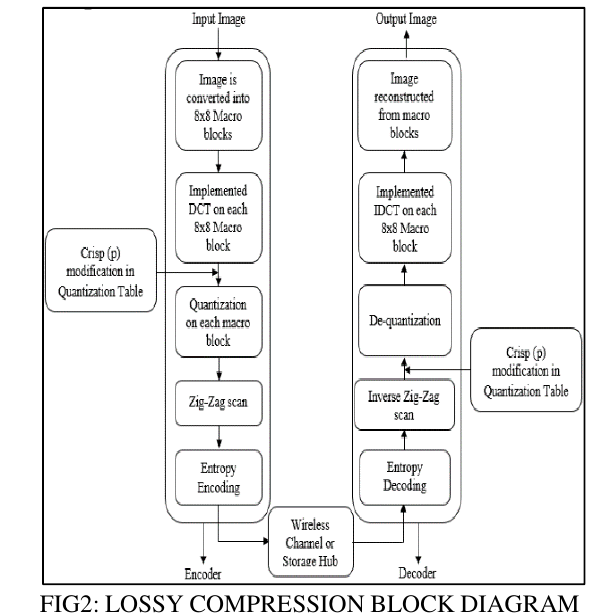
FIG2: LOSSY COMPRESSION BLOCK DIAGRAM WITH p FACTOR